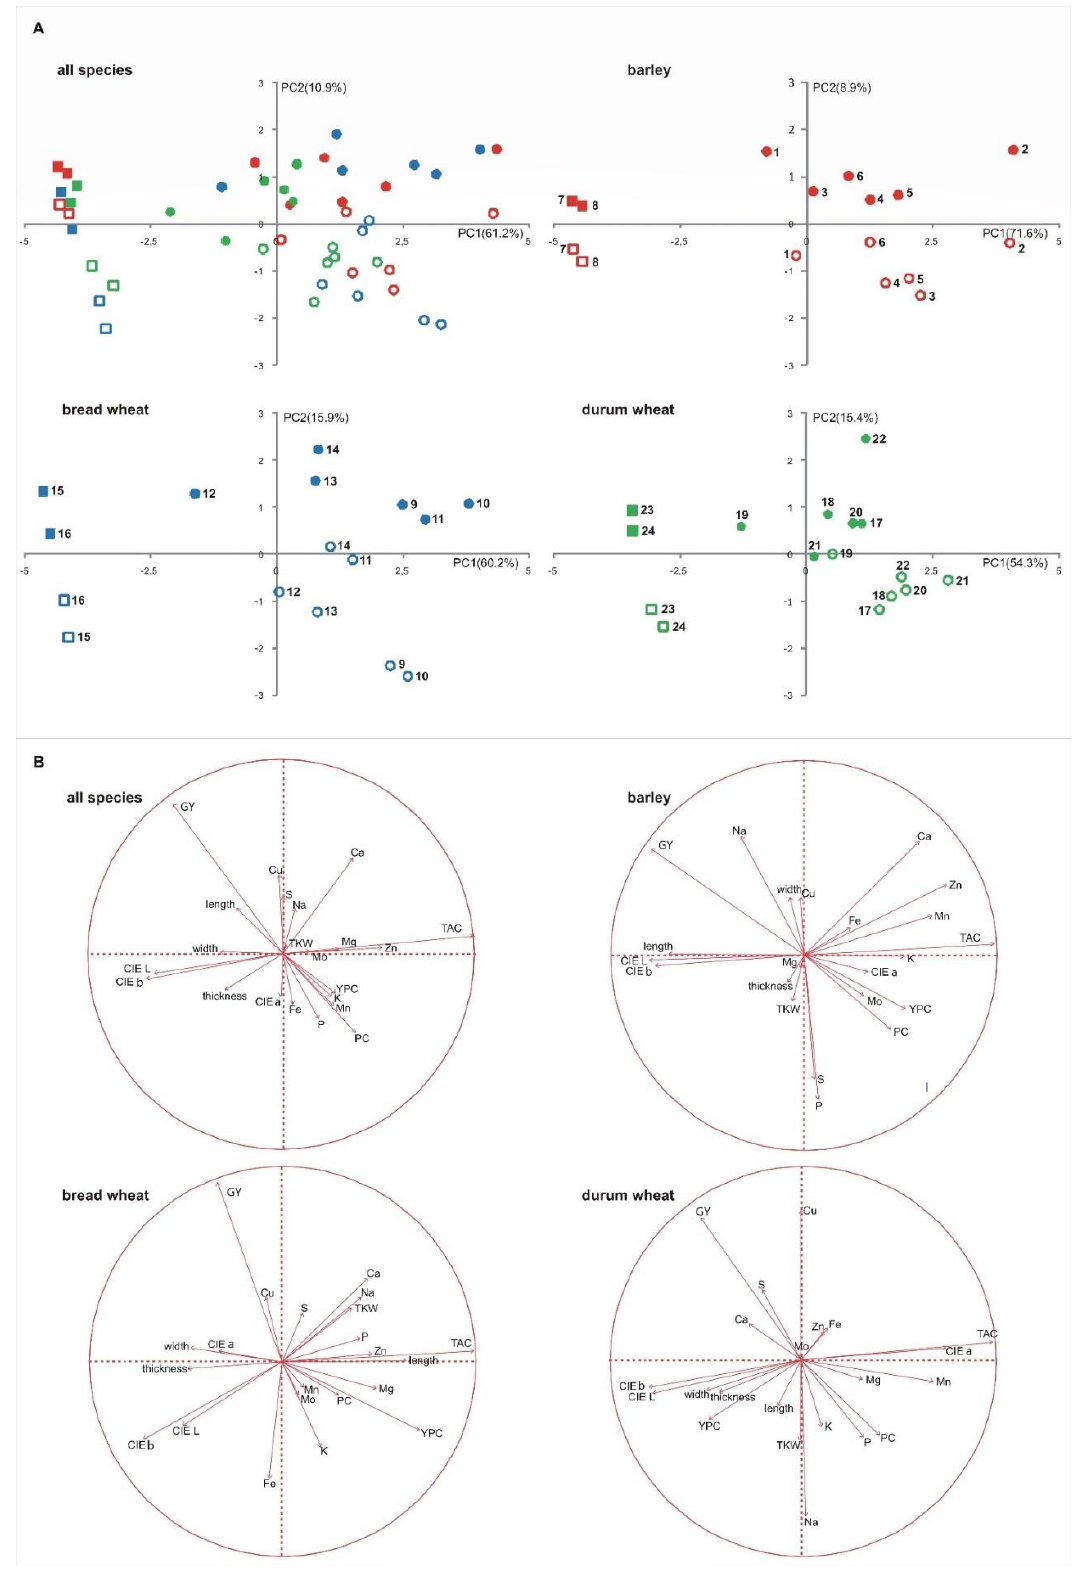
Figure 1. PCA score plots ( A ) showing the distribution of the genotypes investigated. Each genotype was numbered accord- ing to Table 1, pigmented genotypes are represented by circle, commercial varieties are represented by square. Full shape, winter sowing; empty shape, spring sowing. PCA loading plots ( B ) showing the distribution of the analyzed